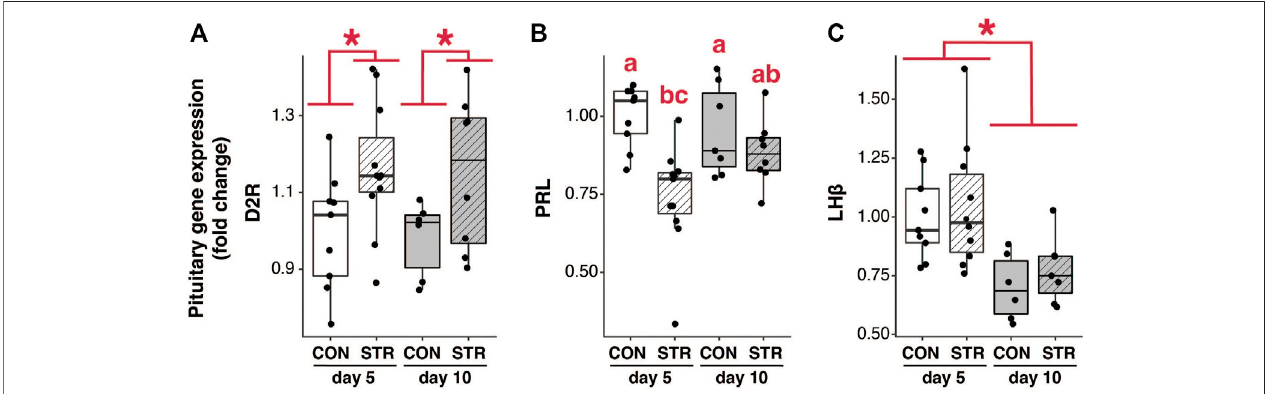
FIGURE3| TheimpactofstressonpituitarymRNAexpression. (A) Pituitary D2receptor (D2R)mRNAexpressionwasincreasedinbothearly-andmid-pregnancy by chronic psychological stress exposure. (B) Pituitary Prl mRNA expression was attenuated by stress in early-, but not mid-pregnancy. (C) pituitary LH β mRNA